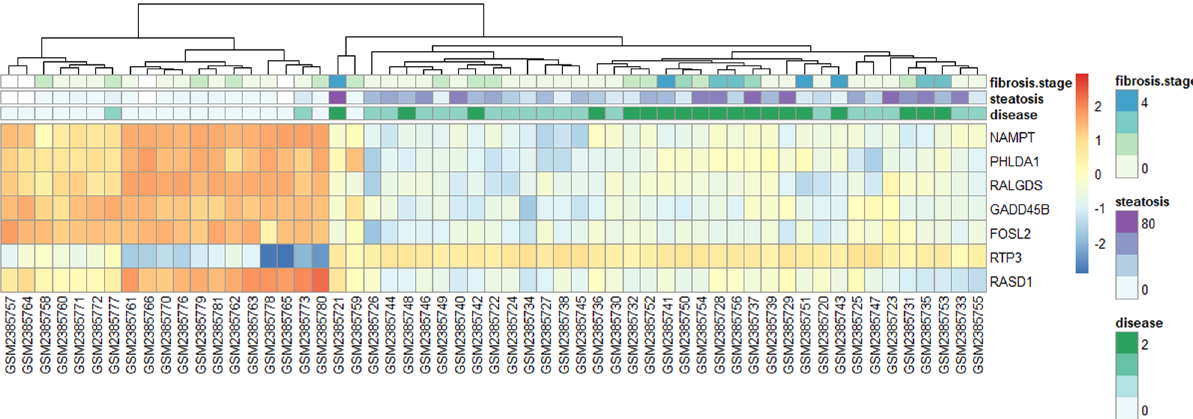
Figure 3: Heatmap of hub genes and samples. Each column represented one sample in the dataset GSE89632, which was annotated by clinical data in di ff erent pairs of colors. Samples were clustered. For disease, 0 ( white ) , 1, 2 ( green ) represented normal sample, steatosis sample, NASH sample respectively. For steatosis, 0 ( white ) to 80 ( purple ) represented steatosis percentage. 0 ( white ) to 4 ( blue ) repre - sented the fi brosis stage. Each row represented each hub gene. The expression of each hub gene in each sample was presented by red to blue. Red and blue represented high expression and low expression,